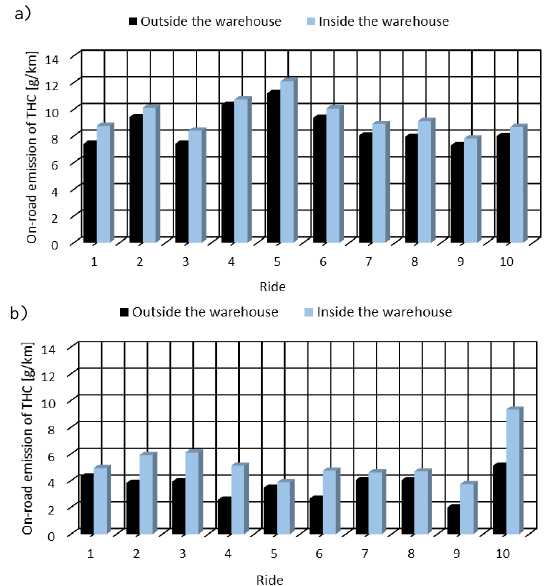
Fig. 11. On-road emission of THC of a forklift truck fitted with a SI LPG engine: a) when carrying a load b) when driving unloaded